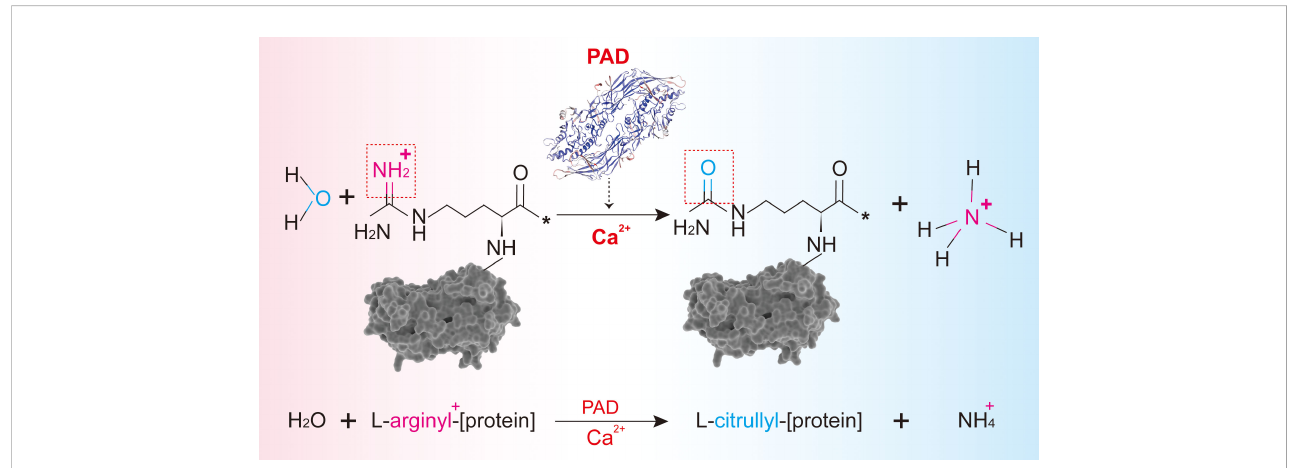
FIGURE 1 The process of citrullination mediated by PAD. (A) Protein citrullination mediated by PADs. (B) Primary substrates, distribution, and physiological functions of PADs.